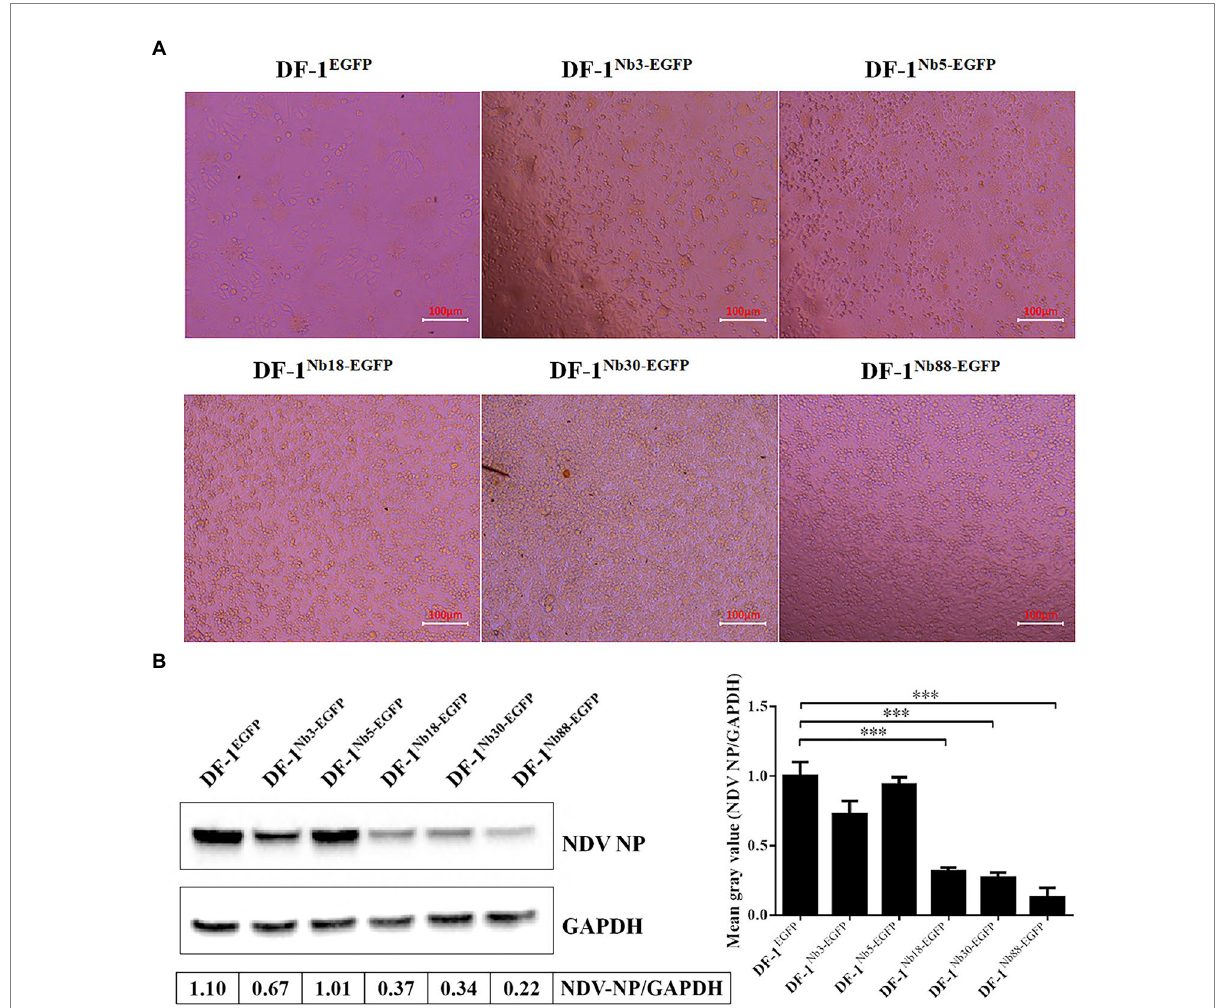
FIGURE 5 Analysis of the six recombinant DF1 cell lines inhibiting NDV LaSota strain replication. (A) Cytopathic effects of the six recombinant DF1 cell lines inoculated with 0.01 MOI of NDV LaSota strain. (B) Expression levels of NDV NP protein in different recombinant DF1 cell lines inoculated with NDV LaSota strain, as measured by Western blotting using anti-NDV NP mAbs as primary antibodies. The results were performed in triplicate and data are presented as the mean ± SD. * p < 0.05; ** p < 0.01; *** p < 0.005 (two-tailed Student’s t